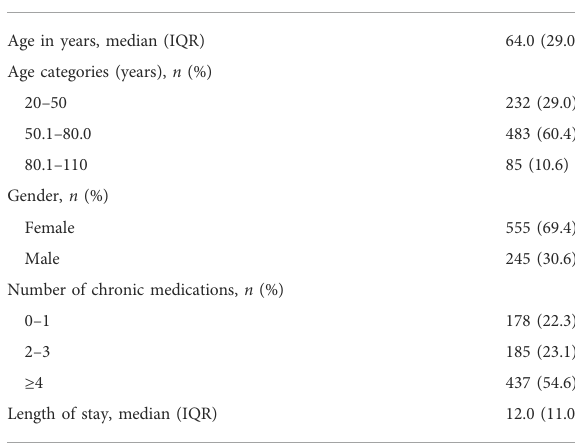
TABLE 1 Demographic and medical characteristics of the study sample ( n =